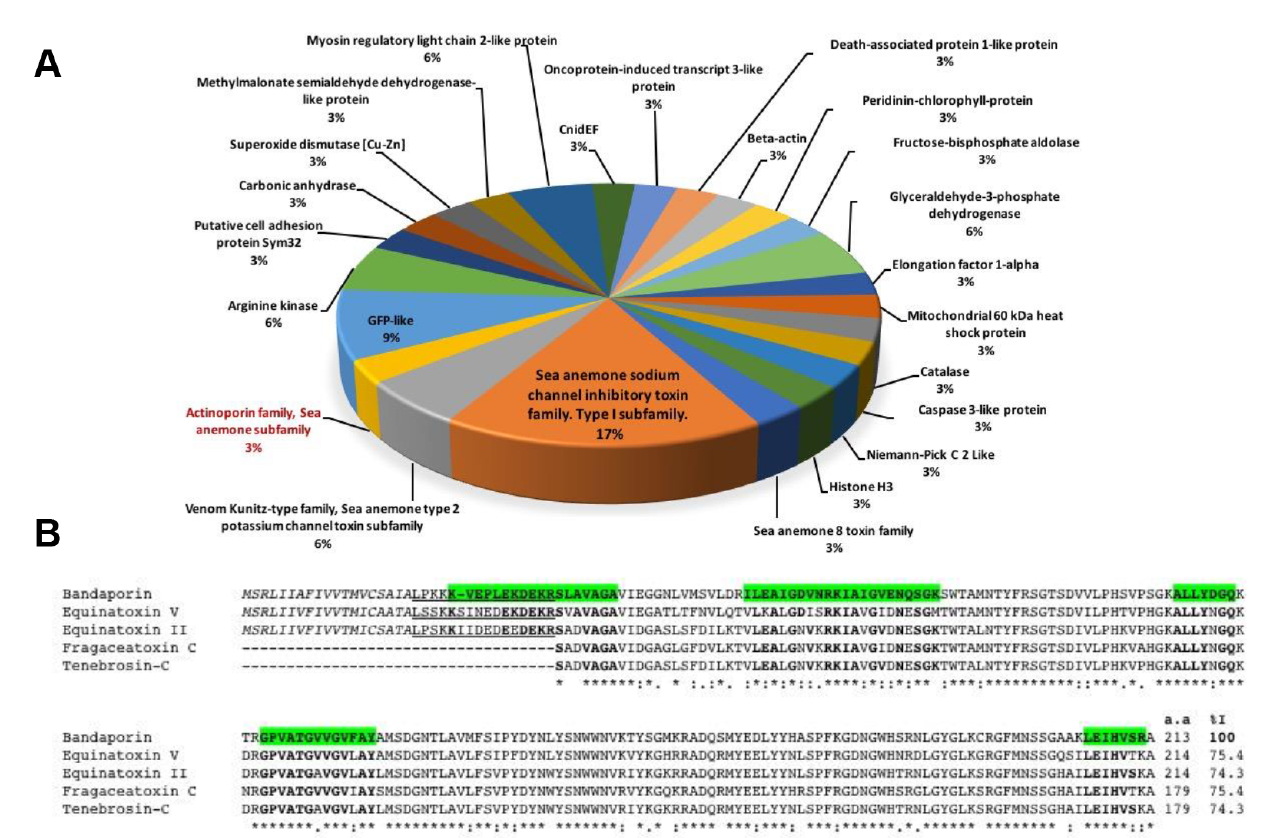
Figure 4 Distribution of the components identified by MS / MS in the F1 fraction and multiple alignment of actinoporins showing the region covered by the tryptic peptides. A. Relative proportions of the polypeptides identified using the Anthopleura and Actiniidae databases from UniprotKB. B. Multiple alignment of bandaporin (DELTA-actitoxin-Aas1a) from Anthopleura asiatica , Equinatoxin II (DELTA-actitoxin-Aeq1a) and V (DELTA-actitoxin-Aeq1b) from Actinia equina , Fragaceatoxin-C (DELTA-actitoxin-Afr1a) from Actinia fragacea and Tenebrosin-C (DELTA-actitoxin-Ate1a) from Actinia tenebrosa . The region covered by the triptych peptides in the bandaporin sequence is highlighted in green. In all sequences, the residues conserved with the region covering the tryptic peptides appear in boldface. The signal peptide is in italics and the propeptide region is